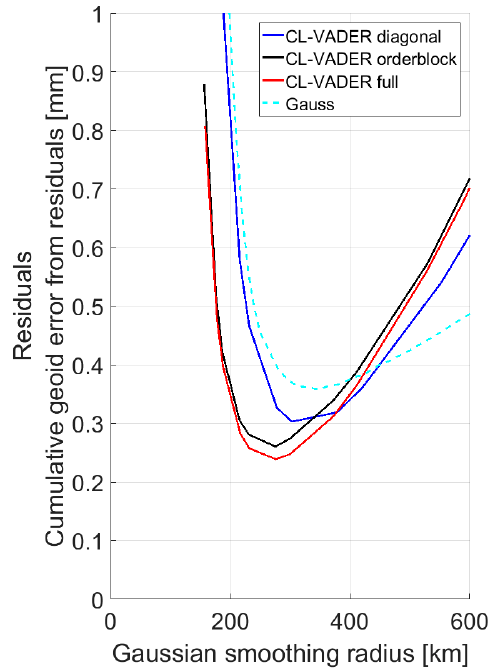
Figure 3. Cumulative geoid errors in mm for different VADER filter radii (average) computed from the residuals of all monthly solutions (median is shown) with respect to the corresponding HIS signal using full error variance-covariance matrices (red), only SH order blocks (black), and only the diagonals (blue) compared with the Gaussian filtered solutions (dashed cyan).